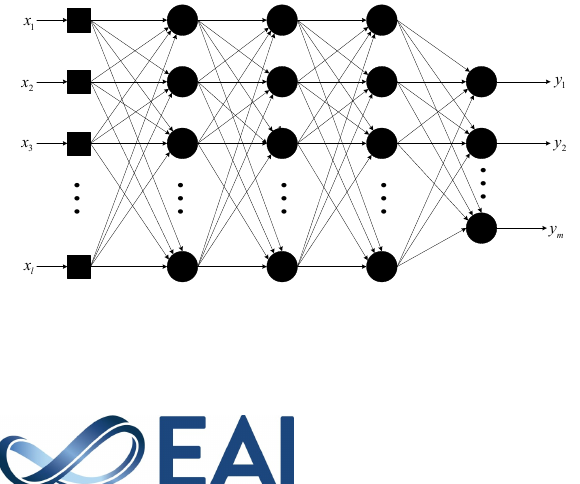
Figure 2. The step function of the perceptron